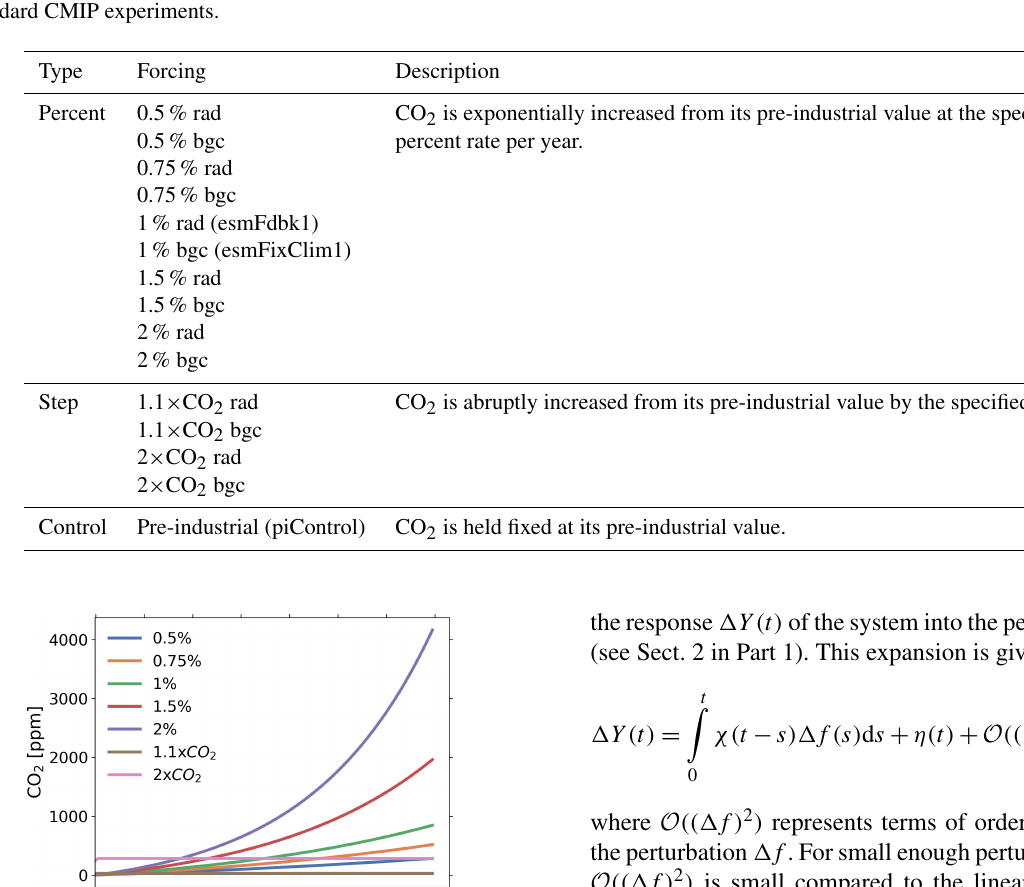
Table 1. C 4 MIP-type experiments considered in this study. Forcings are shown in Fig. 1. Abbreviations “rad” and “bgc” refer to standard CMIP model setups used to calculate the climate-carbon cycle sensitivities. In the “rad” (radiatively coupled) setup only the radiation code of the model is affected by changes in atmospheric CO 2 . This setup is used to calculate γ . In the “bgc” (biogeochemically coupled) setup only the biogeochemistry of the model is affected by changes in atmospheric CO 2 . This setup is used to calculate β . In brackets are names of standard CMIP experiments.